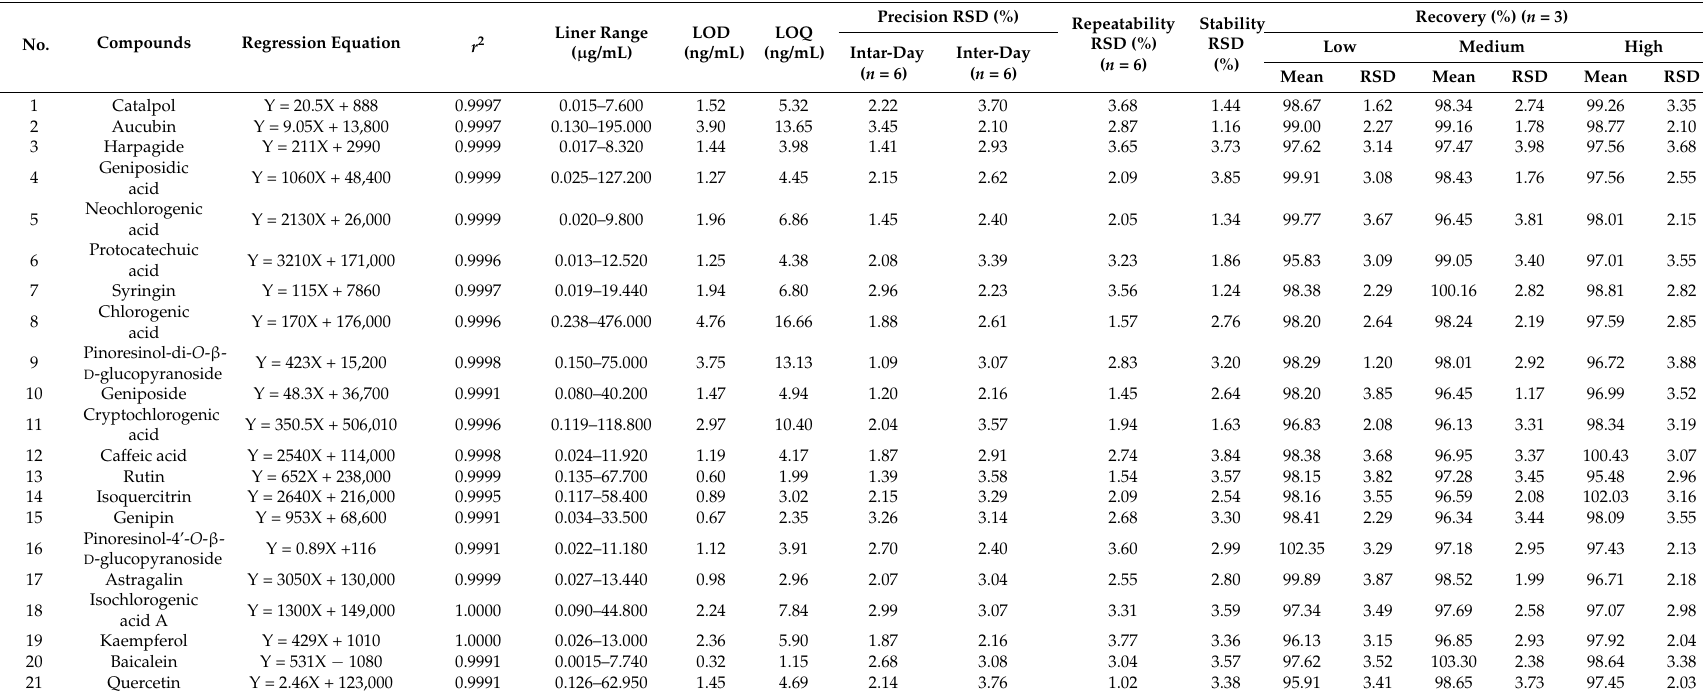
Table 2. Regression equation, LOD and LOQ, precision, repeatability, stability, and recovery of 21 investigated